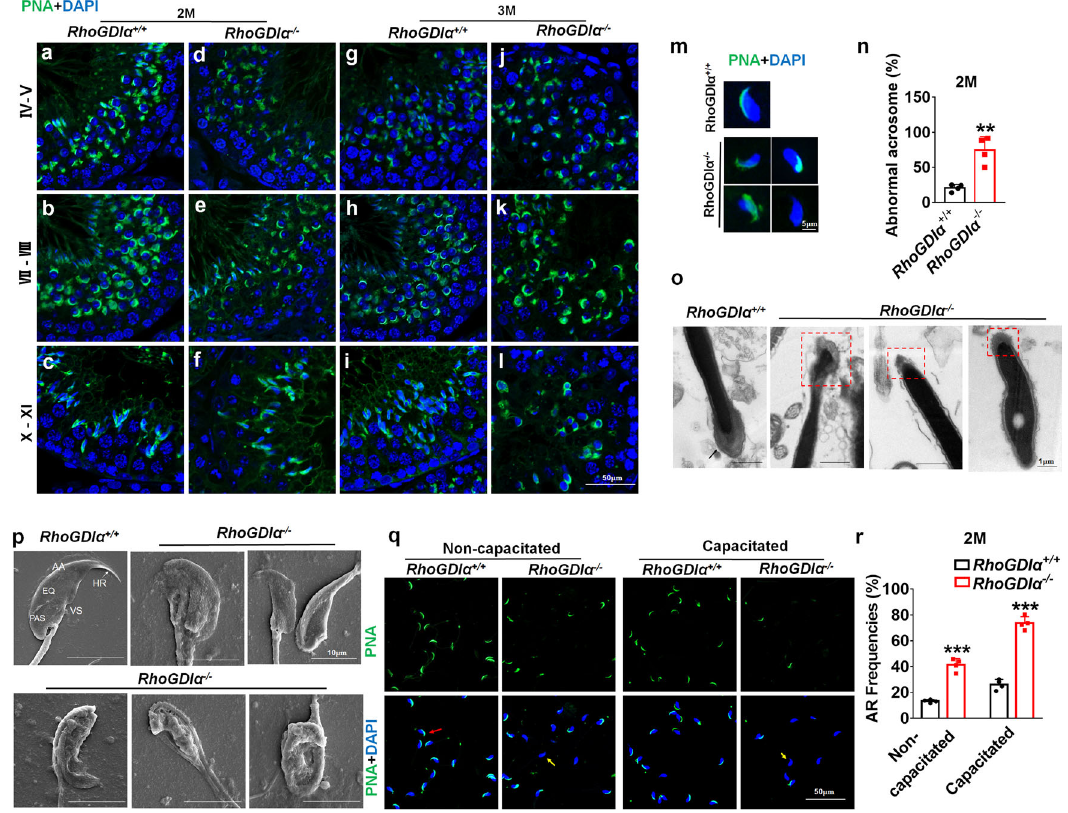
Fig. 3 RhoGDI α is essential for acrosome morphology and function development. a-l FITC-labeled PNA was used to examine acrosomes at different developmental stages in RhoGDI α + / + and RhoGDI α − / − mice at 2 months and 3 months of age. Scale bar = 50 μ m. m Acrosome morphology of sperms in the caudal epididymis from 2-month-old RhoGDI α + / + and RhoGDI α − / − mice. Scale bar = 5 μ m. n Statistics of abnormal sperm proportion in mouse caudal epididymis. n = 4 biologically independent animals. o TEM images of the sperm acrosomes in 2-month-old RhoGDI α + / + and RhoGDI α − / − . Scale bar = 1 μ m. p SEM images of epididymal sperms from 2-months RhoGDI α + / + and RhoGDI α − / − mice. PAS Postacrosomal segment, EQ equatorial segment, AA anterior acrosome, HR hook rim, VS ventral spur. Scale bar = 10 μ m. q , r Pictures and statistics of spontaneous AR frequencies in noncapacitated or capacitated sperms. Red arrow, normal acrosome; yellow arrow, spontaneous AR acrosome. Scale bar = 50 μ m. n = 4 biologically independent animals. ** P < 0.01, *** P < 0.001 vs RhoGDI α + / + . Data are presented as the mean ± standard